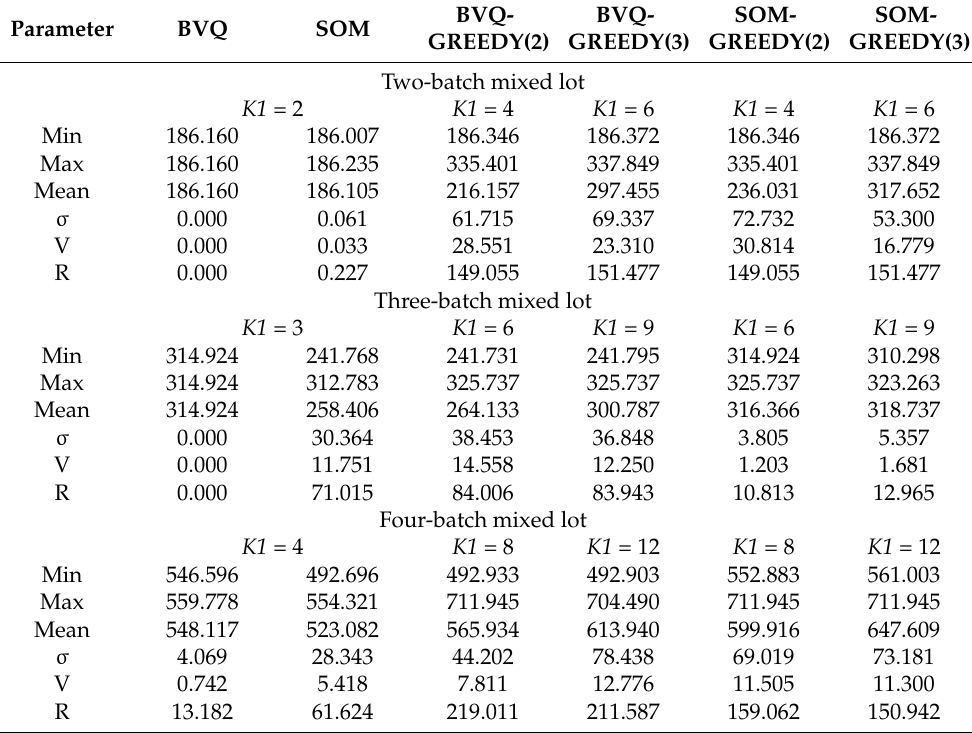
Table A5. Objective function value summarized after 30 attempts (Euclidean distance, initialization by k-means).